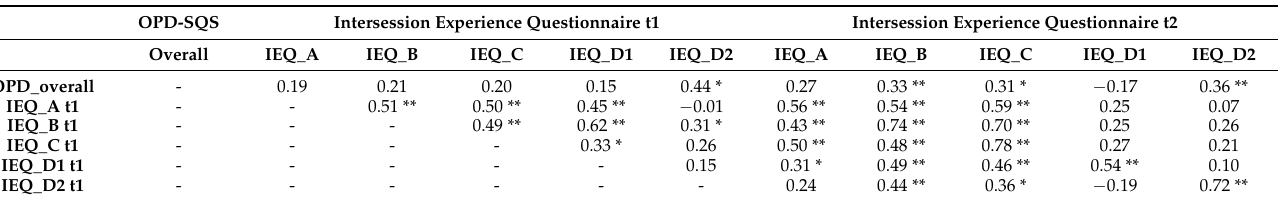
Table 3. Correlation matrix between the OPD-Structure Questionnaire Short (OPD-SQS) and Interses- sion Experience Questionnaire (IEQ) for T1 and T2.